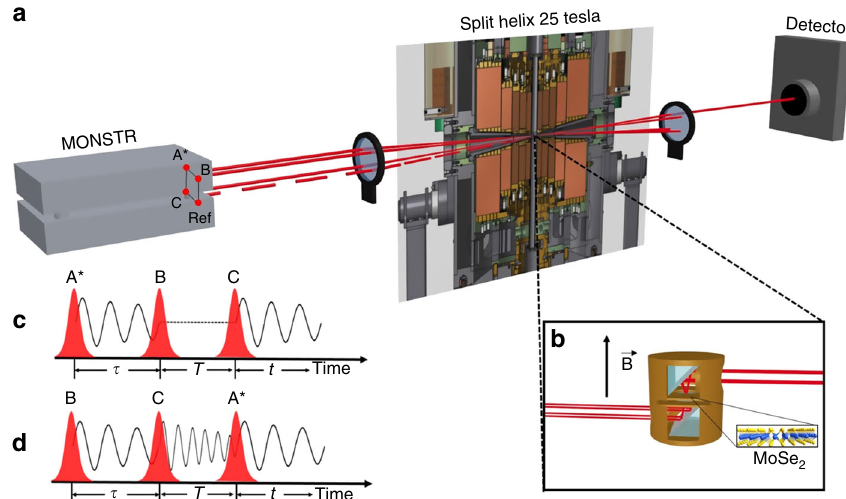
Fig. 1 Experiment. a Schematic of the experimental setup: The three laser beams are provided by the multidimensional optical nonlinear spectrometer (MONSTR) 57 . Three beams labeled as A * , B, and C are used to generate the FWM signal, where A * corresponds to the phase conjugate beam. The beams are aligned in the three corners of a square. The FWM signal generated at the sample propagates along the missing corner (direction − k collected by the detector. The samples are kept at 10 K inside the magneto-optical cryostat. b The magnetic fi elds up to 25 T are applied perpendicular to the sample surface in Faraday geometry. c Pulse sequence leading to positive delay FWM signal. d When the phase conjugate pulse A * arrives last, the negative delay signal is generated due to multiple exciton correlations